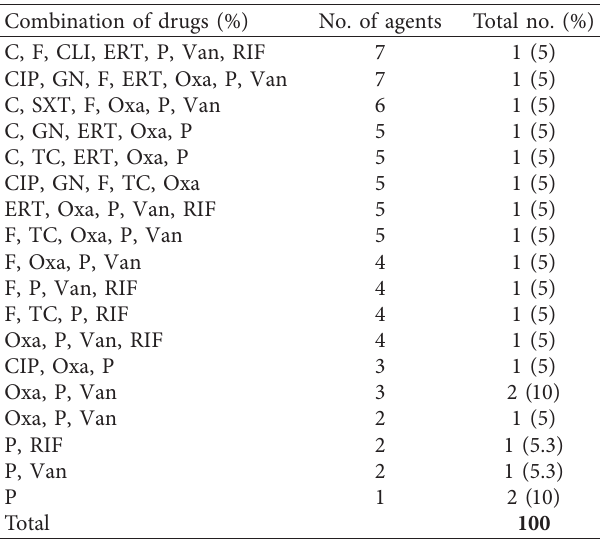
Table 5: Drug resistance patterns of Gram-positive isolates among patients in surgical wards at the Halibet and the Orotta National Referral Hospital in Asmara, Eritrea, 2017. Combination of drugs